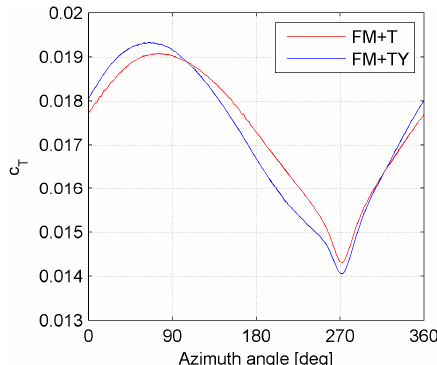
Figure 17. Torque coefficient contribution of each blade as a function of its azimuth angle: FM + T vs. FM + TY.